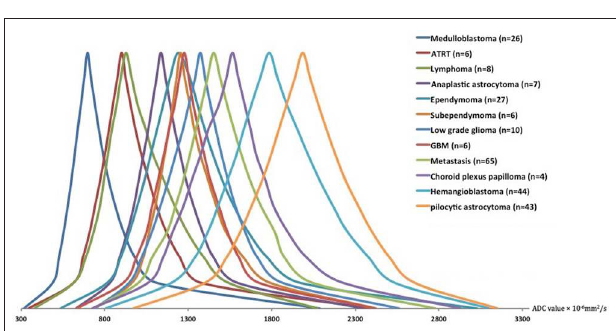
FIGURE 4 | The schematic representation of the averaged ADC histogram distribution among different posterior fossa neoplasms. Medulloblastomas, ATRT, and lymphomas had the lowest; whereas, pilocytic astrocytomas, and hemangioblastomas had the highest ADC histogram percentile values. The average percentile values for each tumor type were calculated, and representative averaged histograms were modified so that the median values would be depicted at the same height on the y axis. ADC, apparent diffusion coefficient; ATRT, atypical teratoid/rhabdoid tumors; GBM, glioblastoma